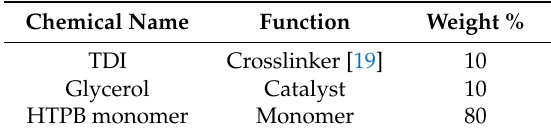
Table 1. Composition of hydroxyl terminated polybutadiene (HTPB) in toluene mixture.